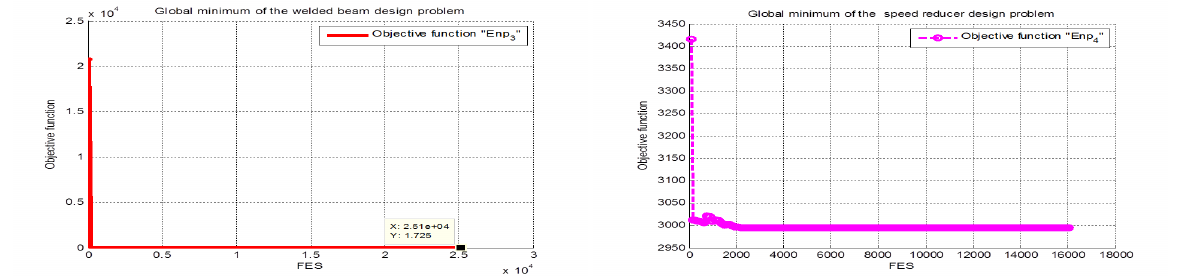
Figure 10. Convergence graph for engineering problems (Engp3 and Engp4